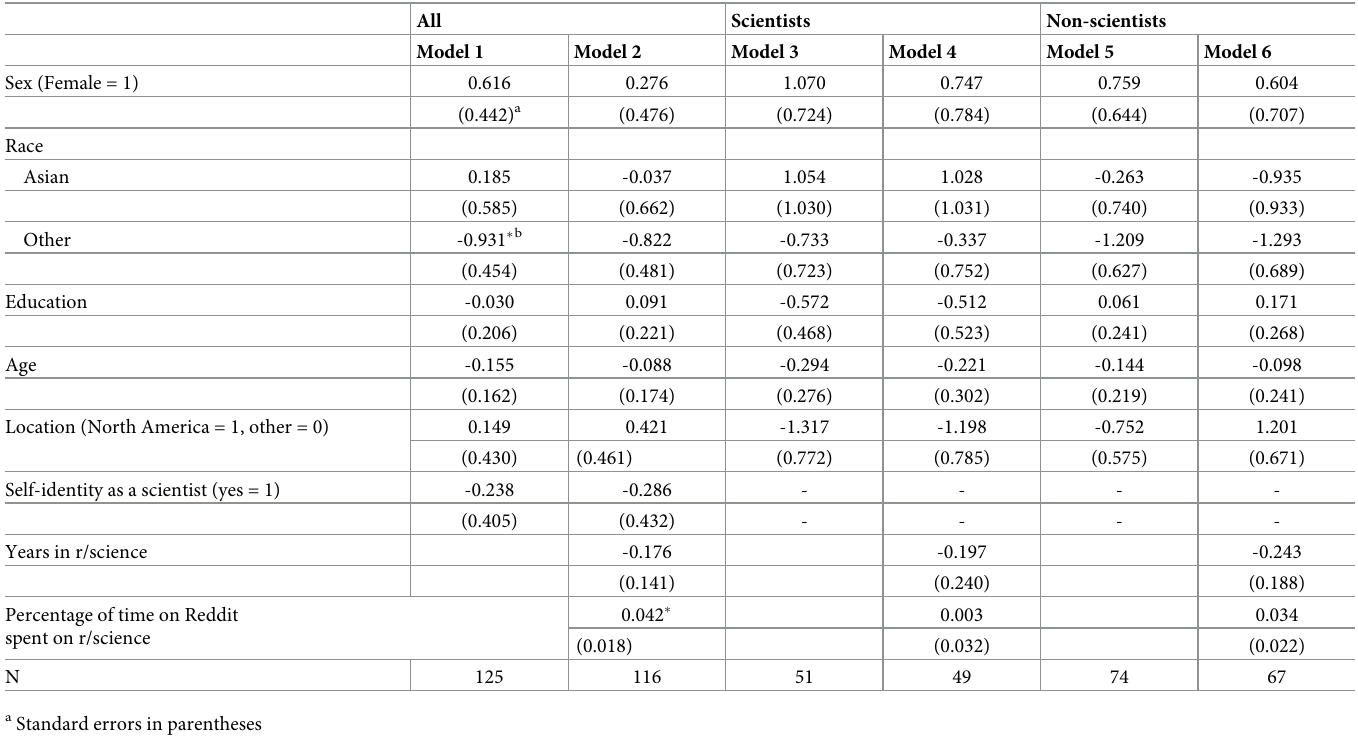
Table 6. Results of ordinal logistic regression of users’ demographics on the perceived effect of r/science being helpful with regard to informing participants.